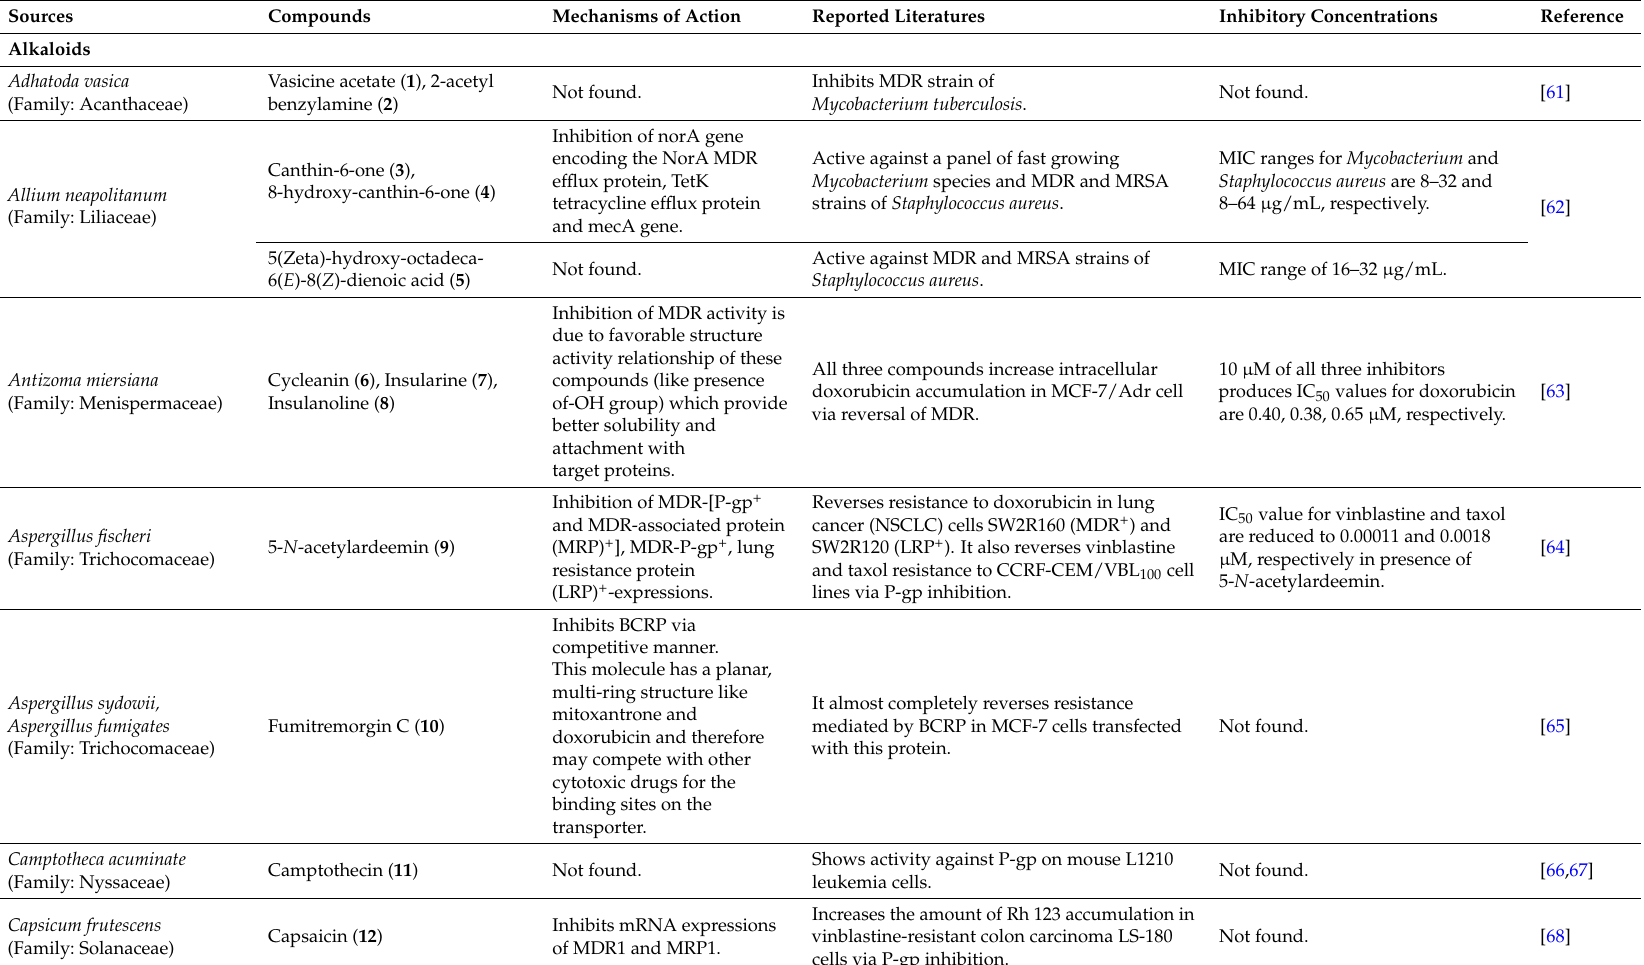
Table 3. Different drug efflux pump inhibitors from natural